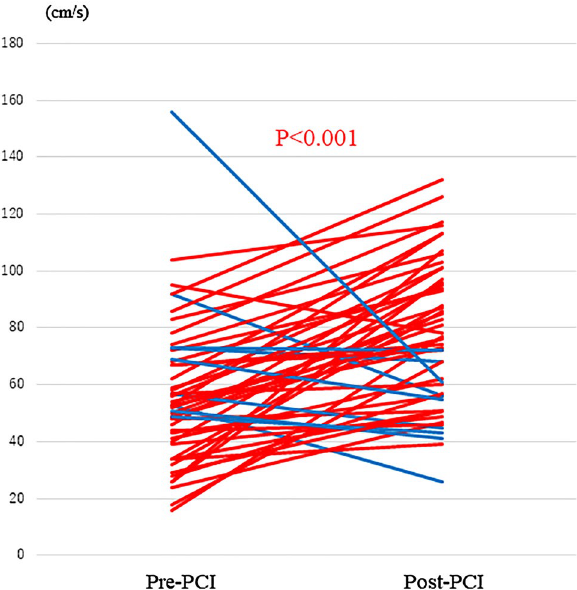
Figure 2. Serial changes in hDPV after PCI. hDPV significantly increased from 53.0 to 76.0 mm/s (P < 0.01), while hDPV decreased in 10 patients (20.0%). Red lines indicate cases with increased hDPV after PCI, and blue lines indicate cases with decreased hDPV after PCI. Abbreviations as in Fig.